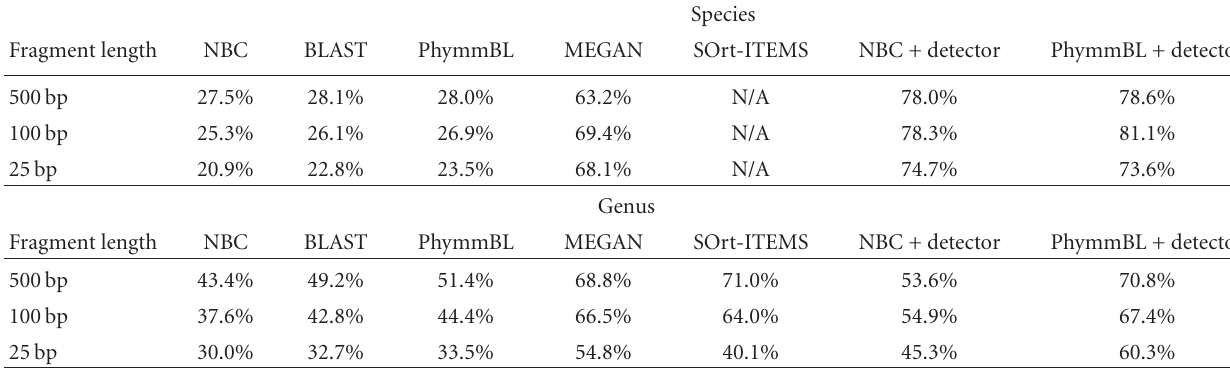
Table 2: Comparison of overall classification accuracies (the number of reads that are identified as “known” that are classified into their correct class plus the no. of unknowns that are correctly rejected divided by all reads) on the 275-strain test set. Using 5-fold cross-validation, the maximum standard deviation is 1%. NBC, BLAST, and PhymmBL, in their native form, cannot detect “unknown” classes while the methods combined with a detector can. Performance is also compared to MEGAN and SOrt-ITEMS accuracy. N/A is designated for the species-level for SOrt-ITEMS since it did not classify anything below the genus level. SOrt-ITEMS obtains the best performance for 500 bp reads for the genus level but is under the 1% standard deviation threshold to be statistically significant. WebCarma was not included because its overall performance for 500 bp reads was 50% for the species level and 37% for the genus level. Note that the overall classification performance increases dramatically when a detector is added to NBC and